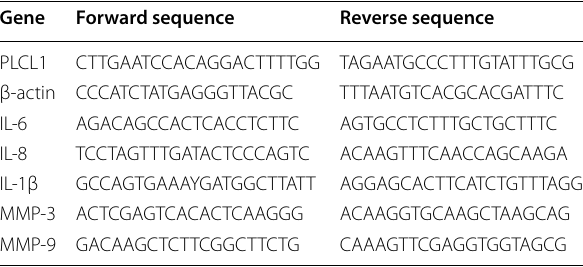
Table 1 Primer sequences for human genes in this study Gene Forward sequence Reverse